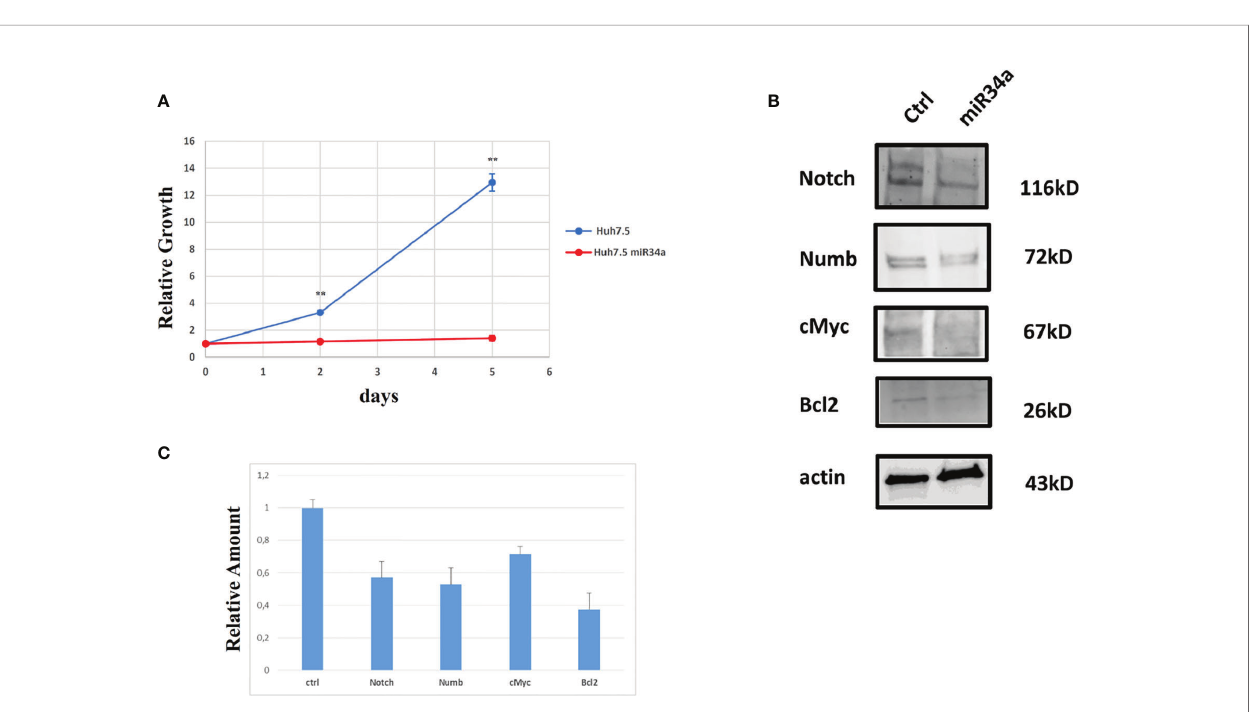
FIGURE 3 | Analysis of Huh7.5 control and overexpressing miR34a: (A) Cell growth curve evaluation by CellTiter-Glo (p value ** ≤ 0.005); data are representative of experiments performed in triplicate on three different samples. (B) Western blot analysis of proteins that have been described as miR34a target and (C) protein quanti fi cation (p value ≤ 0.05); all experiments have been performed in